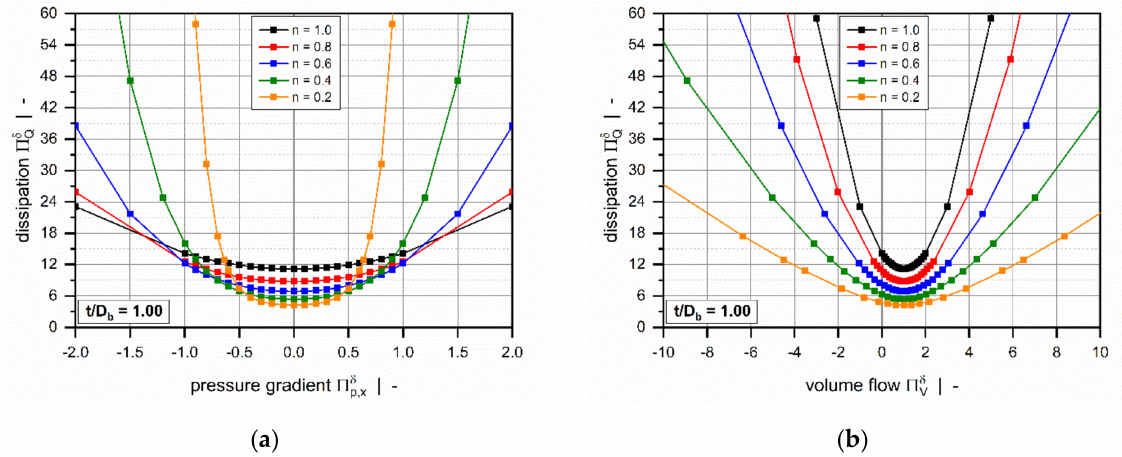
Figure 7. Dimensionless dissipation Π δ as a function of the dimensionless pressure gradient Π δ p , x ( a ) and as a function of the Q dimensionless volume flow rate Π δ . ( b ) The influence of the power-law index for a square-pitched screw with t / D b = 1.0 V